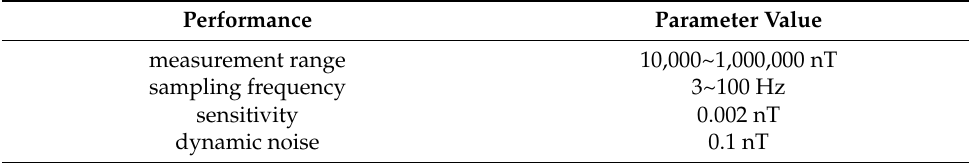
Figure 3. The structure layout of the ROV magnetic field measurement system. Table 1. Main performance specifications of the magnetometer.